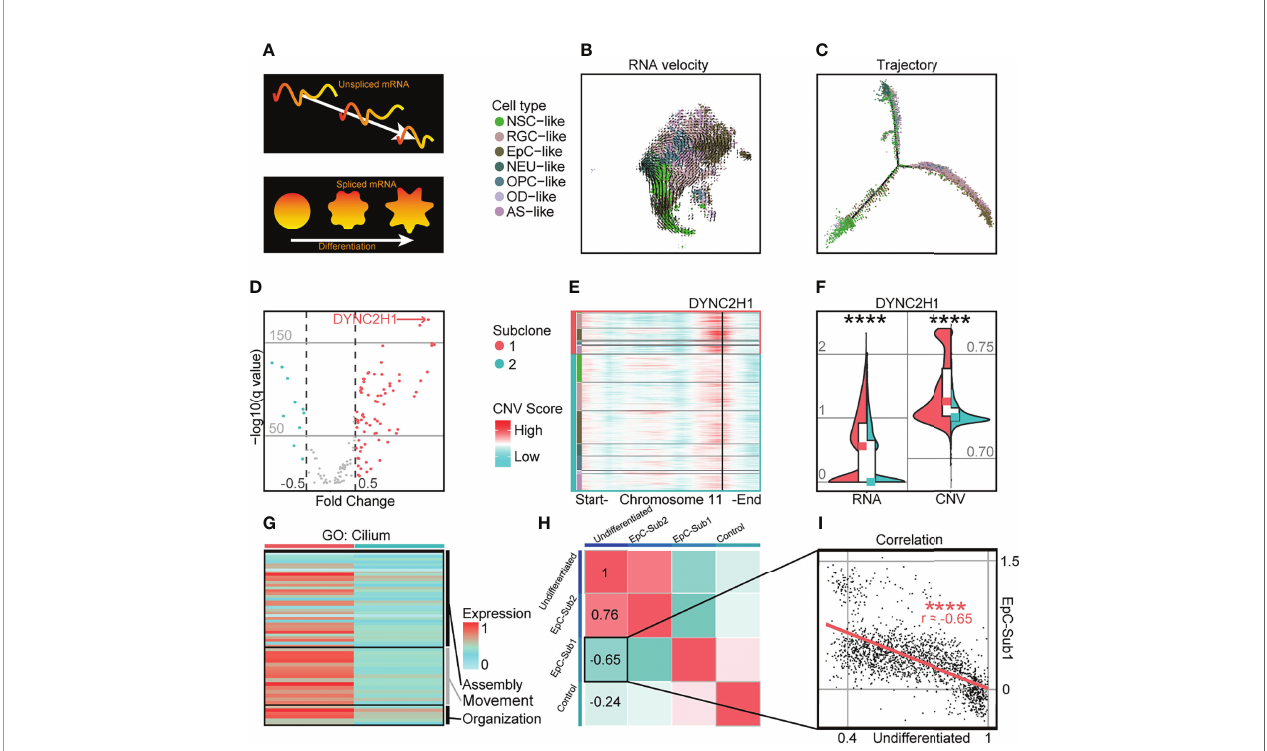
FIGURE 2 | Highly differentiated cells in PF-EPN subclonal populations show CNV ampli fi cation and enrichment of cilium-associated genes. (A) Schematic of RNA splicing analysis and cell differentiation using RNA velocity and trajectory deduction methodologies. (B) RNA velocity inferred by Velocyto and scVelo of malignant tumor cells presented on tSNE reduction and colored by cell types in PF-EPN sample GTE009. (C) Differentiation trajectory inferred by Monocle of malignant tumor cells in PF-EPN sample GTE009. (D) Volcano plot showing genes with differentially expressed CNV values highlighting DYNC2H1 in the PF-EPN sample GTE009 subclone 1 compared to the subclone 2. (E) Heatmap of chromosome 11 showing inferCNV scores colored by cell types designated in Figure 2B and subclone annotation in PF-EPN sample GTE009. DYNC2H1 is highlighted by black vertical bar. (F) Violin plot showing signi fi cant difference ( p < 0.0001; Mann Whitney – test) in gene expression (RNA) and CNV level of DYNC2H1 between subclones in PF-EPN sample GTE009. (G) Heatmap showing relative expression of identi fi ed genes from cilium-related terms in GO analysis (27) colored by subclones in the PF-EPN sample GTE009. (H) Correlation analysis of undifferentiated score in EpC-like cells, normalized average expression of markers in EpC-like cells in subclone 1 (EpC-Sub1) and subclone 2 (EpC-Sub2), and normalized average expression of Mic (Control; see Supplementary Table S2 ) in PF-EPN sample GTE009. (I) Pearson correlation between undifferentiated score and normalized average expression of EpC-Sub1 ( p < 0.0001) in the PF-EPN sample GTE009. The "*" means signi fi cant difference (p-value): * p < 0.05; ** P < 0.01; *** p < 0.001; **** p <